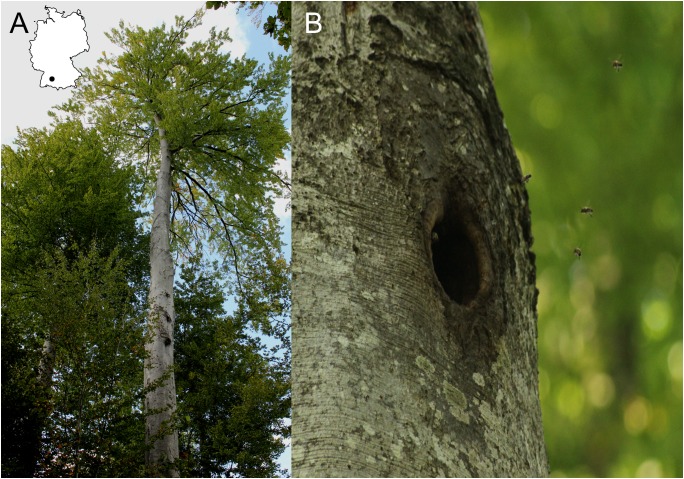
Bee trees in the Swabian Alb.(A) Portrait of a bee tree with three cavity openings made by the black woodpecker. (B) close-up of an old woodpecker cavity occupied by a honey bee colony. Both trees are beech (Fagus sylvatica L.) (Germany map created in R with package “maps” (R Core Team, 2016; Brownrigg, 2017). Photo credit: Patrick Laurenz Kohl).